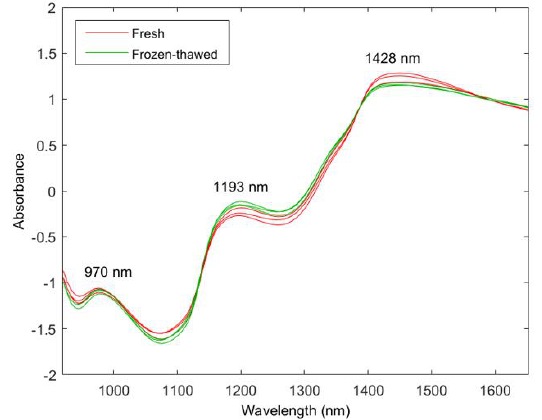
Figure 3. Standard normal variate (SNV) pre-processed mean spectra for fresh ( red ) and frozen– thawed ( green ) zebra, springbok, and ostrich.